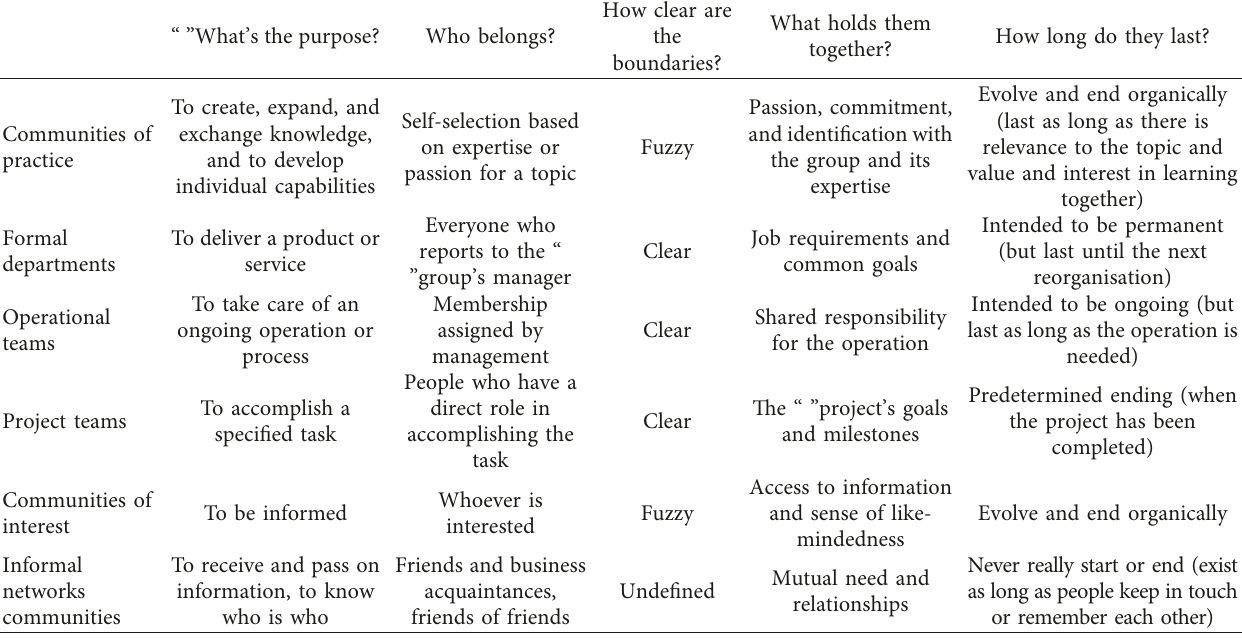
Table 1: Distinctions between communities of practice and other structures